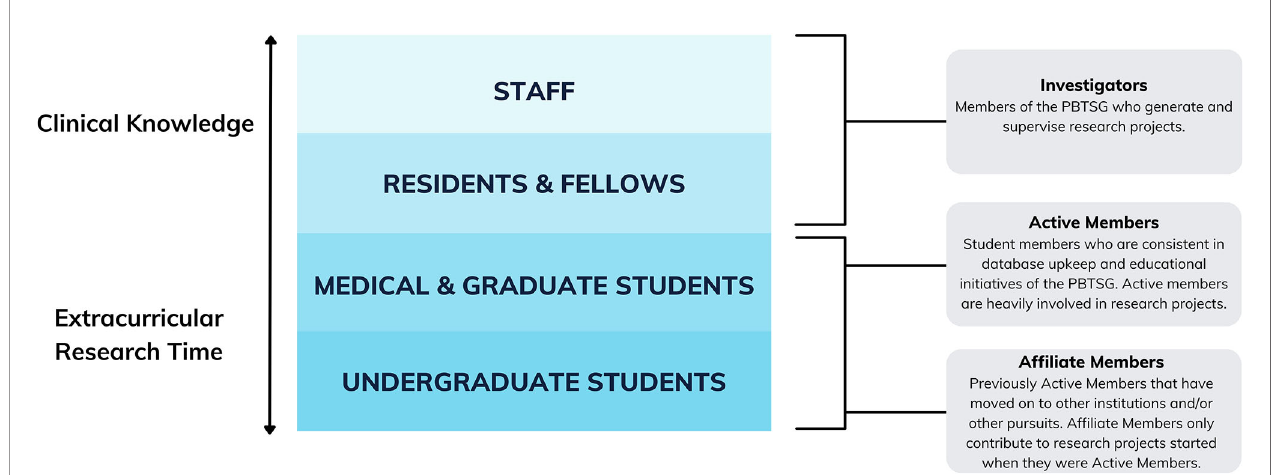
FIGURE 2 | Member tiers of the PBTSG according to clinical knowledge, extracurricular research time, and individual